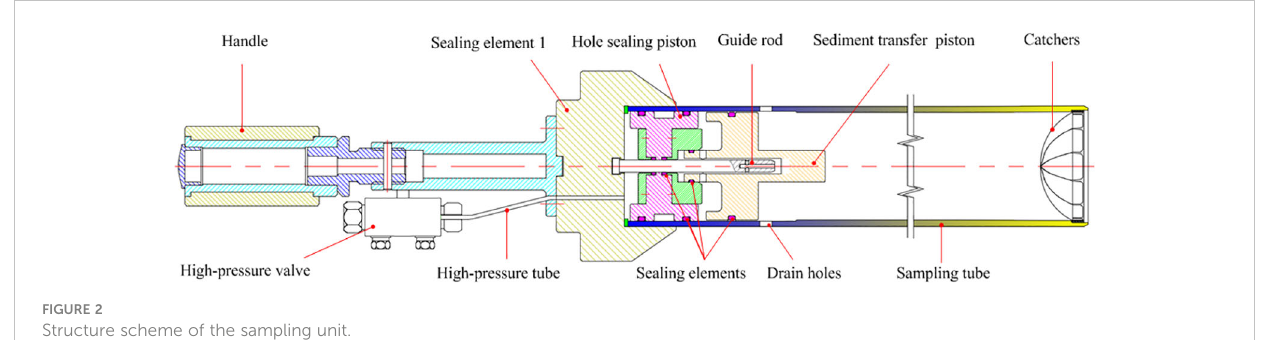
FIGURE 2 Structure scheme of the sampling